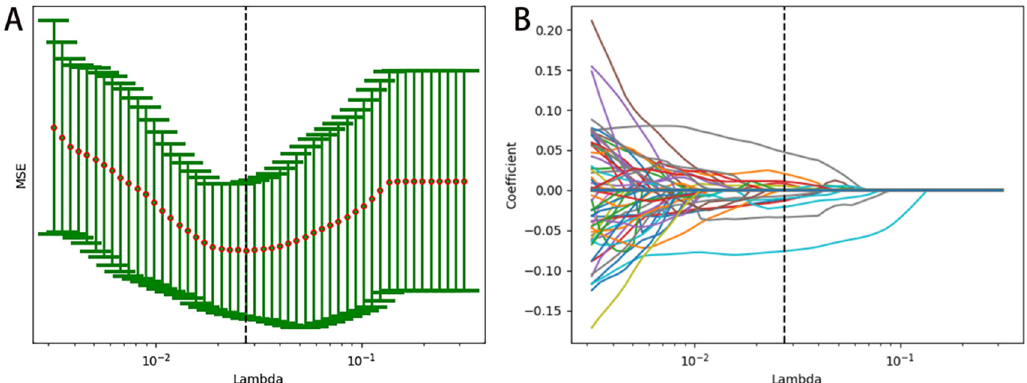
Figure 4. Feature selection and Rad-score building by LASSO. ( A ) A 10-fold cross validation was used to predict mean square error of the Rad-score building by different Lambda values. ( B ) The coefficient profiles of the radiomics features determined by different Lambda values.